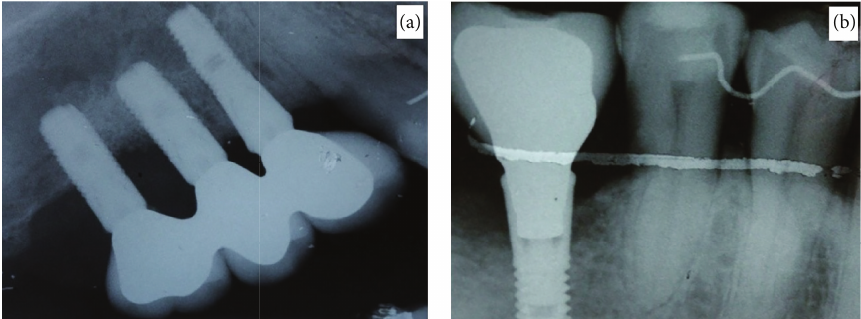
Figure 2: (a) Periapical radiograph that shows bone loss in implants 16 and 17. (b) Periapical radiograph that shows bone involvement in implant